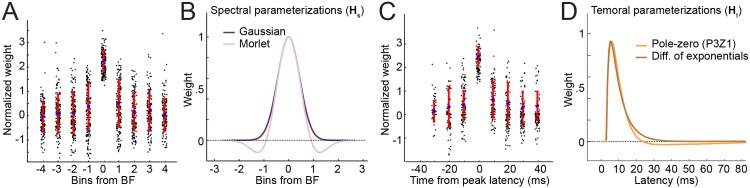
Parameterization of spectral and temporal tuning.
A. Values of factorized spectral weighting matrix H
s, centered about their peak and normalized by variance across all weights. B. Based on the Gaussian-like mean weights and presence of negative values in the sidebands, we parameterized spectral filters using either a Gaussian function or Morlet wavelet. C. Values of the temporal weighting matrix H
t binned at 100 Hz and aligned at peak latency. The -40 ms bin was cropped because very few neurons had peak latency longer than 40 ms. The asymmetric rapid onset and slower fall-off are not well-described by a Gaussian. D. Temporal filters were parameterized using either a difference of exponentials or a pole-zero filter.